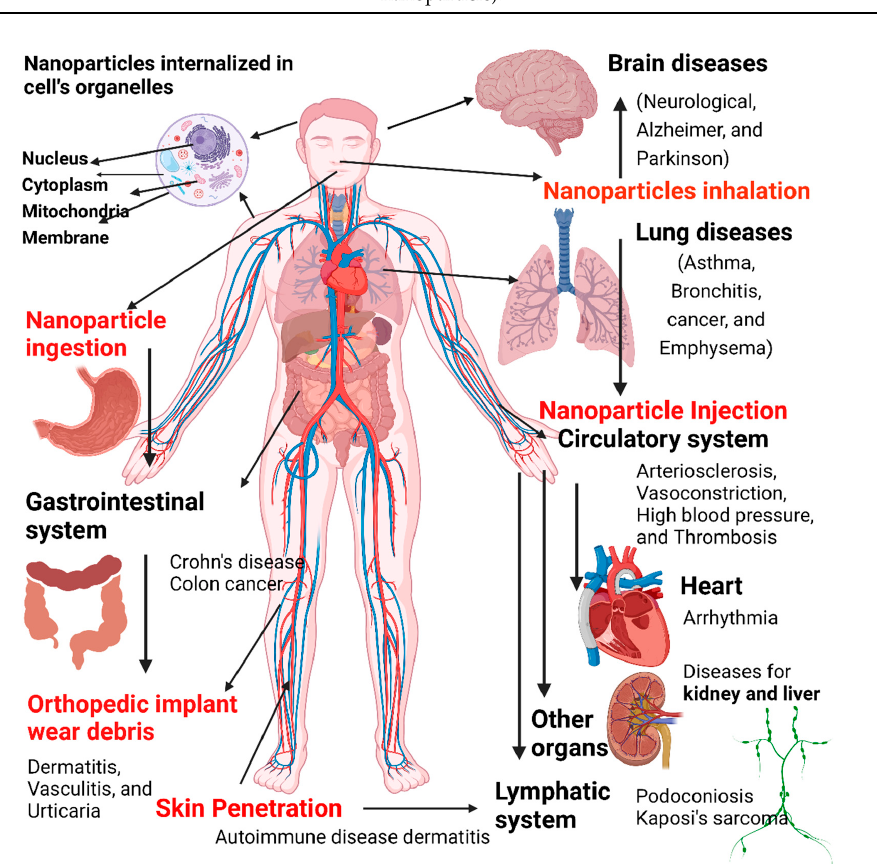
Figure 22. Schematic representation of the nanoparticle exposure routes in the human body, the organs/tissues concerned, and the diseases linked to such exposure (based on the findings of epide- miological, in vivo, and in vitro studies). Table 6. Factors implicated in nanomaterial toxicity.